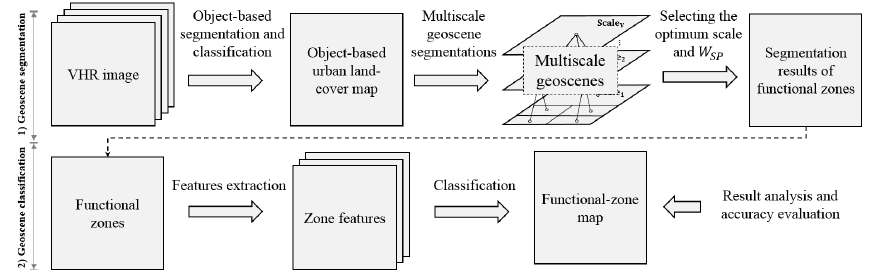
Figure 15. Procedure of mapping urban functional zones.